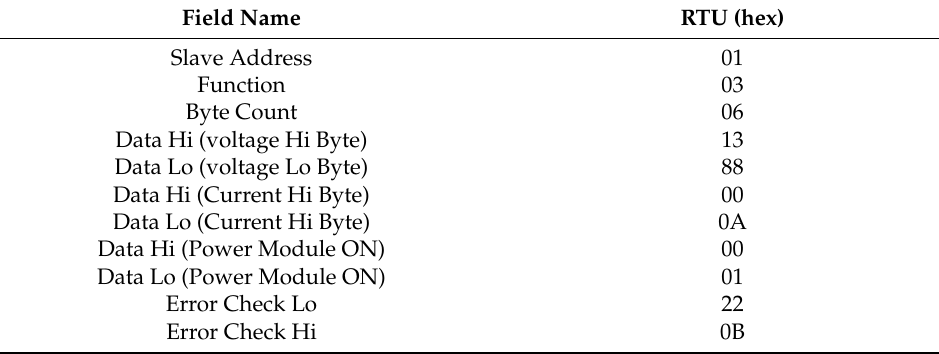
Table A5. Response to read multiple registers from